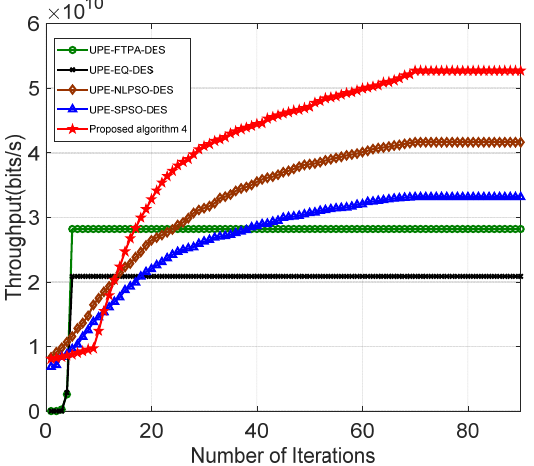
Figure 8. Convergence performance of joint algorithm.